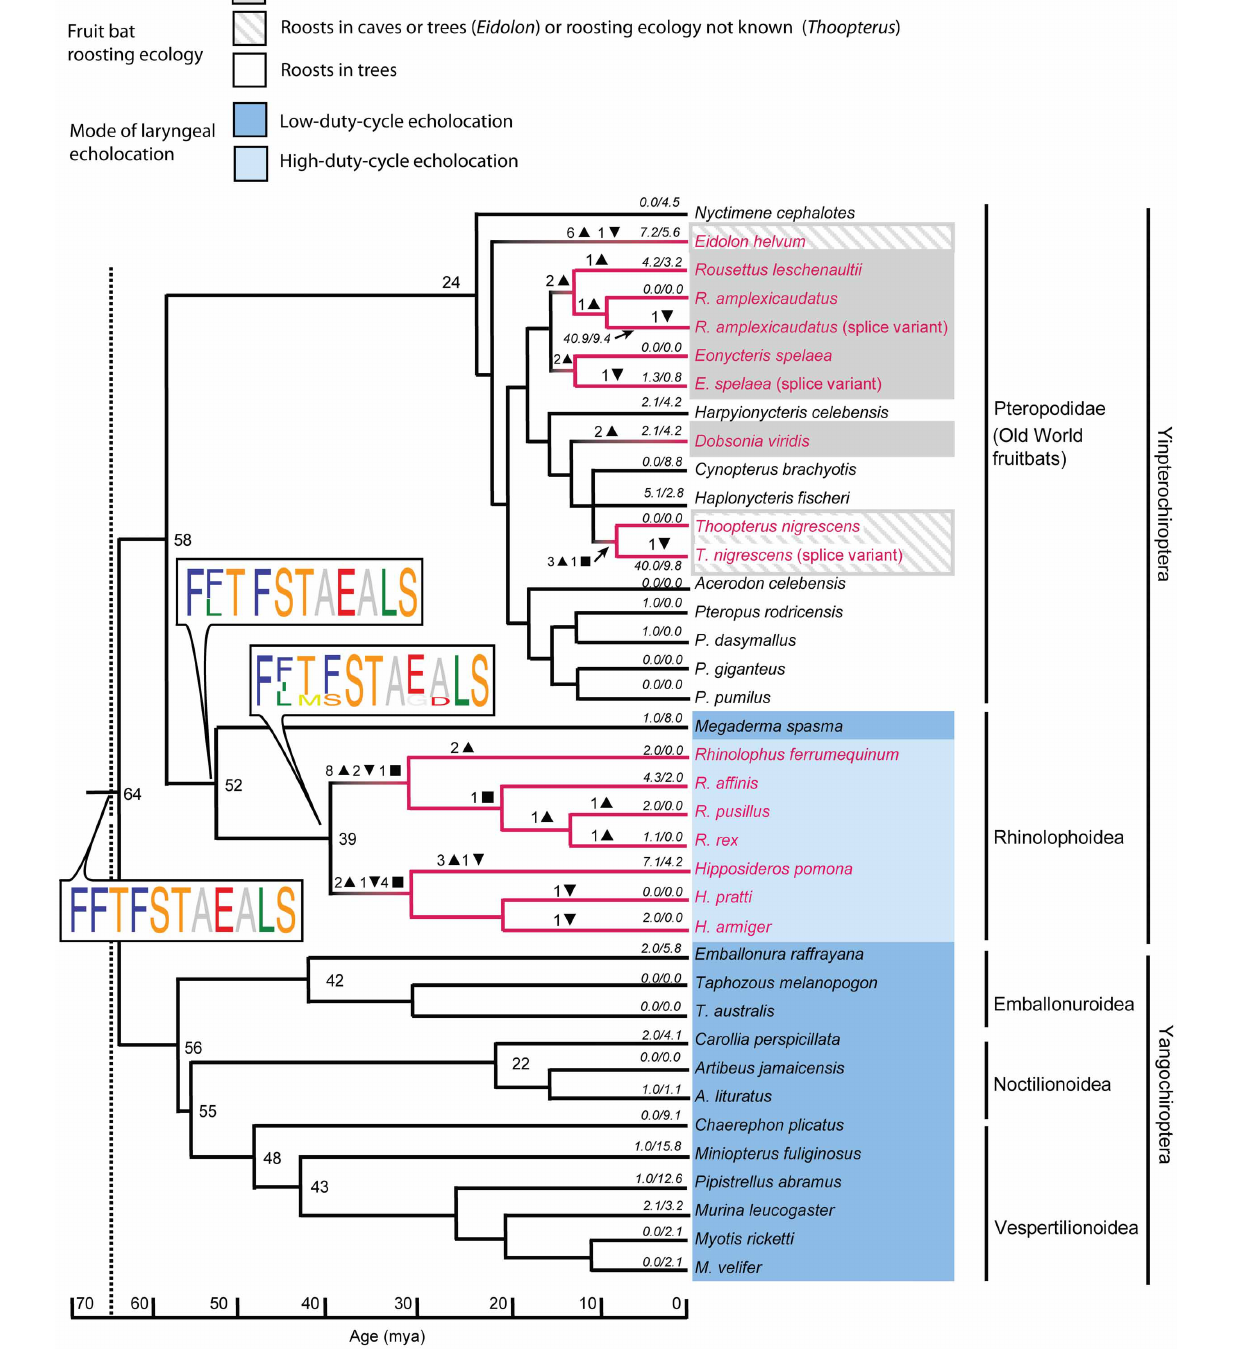
loss-of-function related to the presence of indels or stop codons illustrated by red branches. Branch lengths represent millions of years (MY), and numbers at nodes represent divergence times in MY. Numbers along terminal branches are ratios of non-synonymous to synonymous mutations after removing indels and stops. Note the loss of function associated with high-duty cycle echolocation and with cave roosting in pteropodids. From Zhao et al. (2009b), reproduced with permission from the National Academy of Sciences